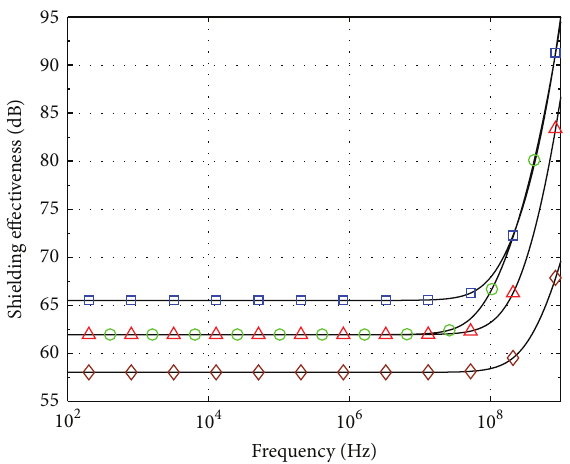
Figure 5: Comparison of shielding effectiveness of the panels in Table 1 by using the proposed method, A ( ◻ ), B ( △ ), C ( ⬦ ), and D ( I ) and the analytical method (—) [23].